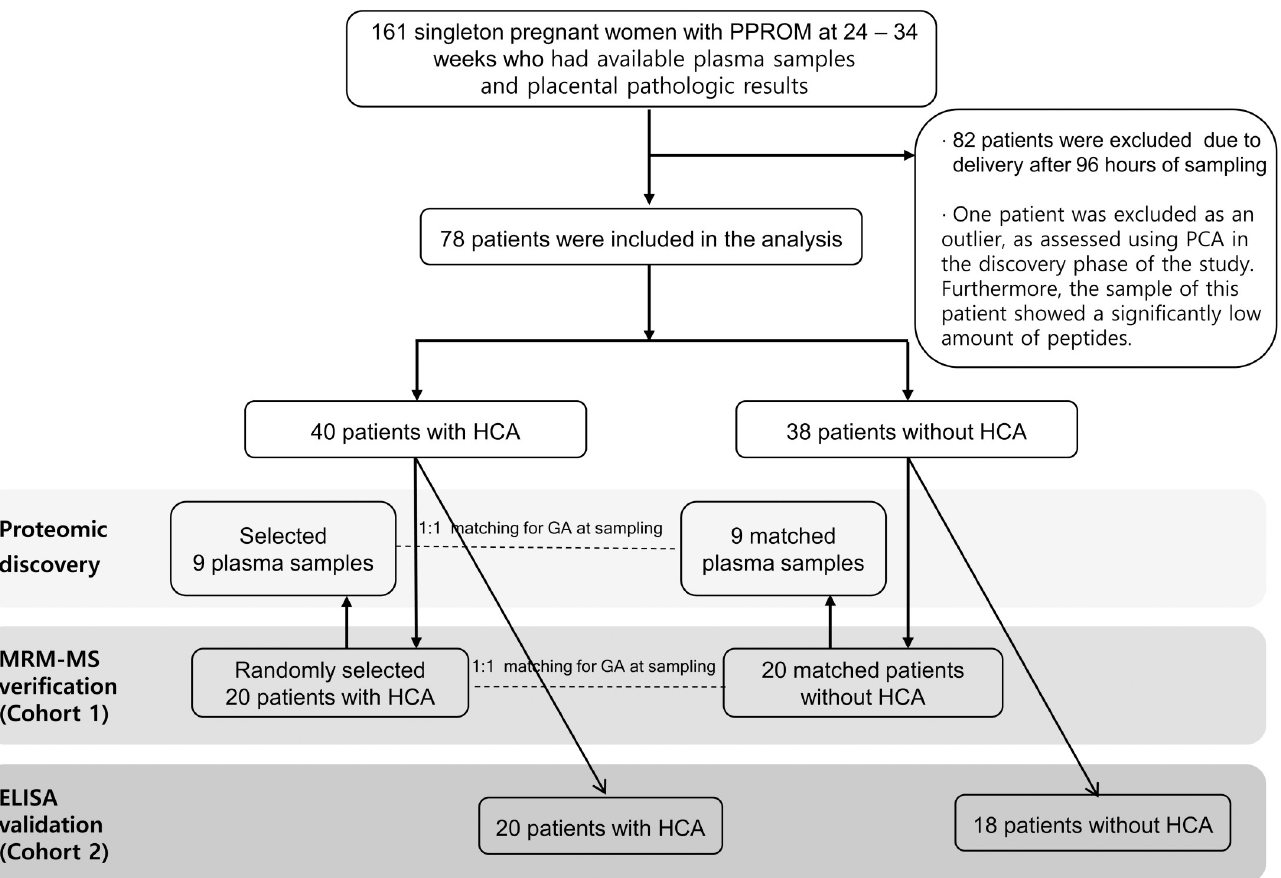
Fig 1. A brief flow chart of patients included in the proteomic and immunoassay analyses. ELISA, enzyme-linked immunosorbent assay; HCA, histologic chorioamnionitis; PPROM, preterm premature rupture of membranes; MRM-MS, multiple reaction monitoring-mass spectrometry.